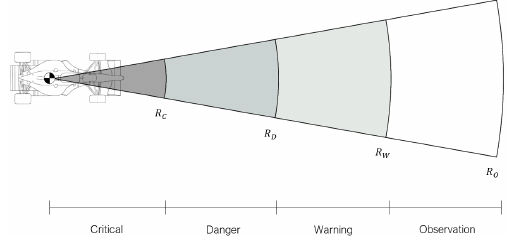
Figure 8. Schematic of the detection